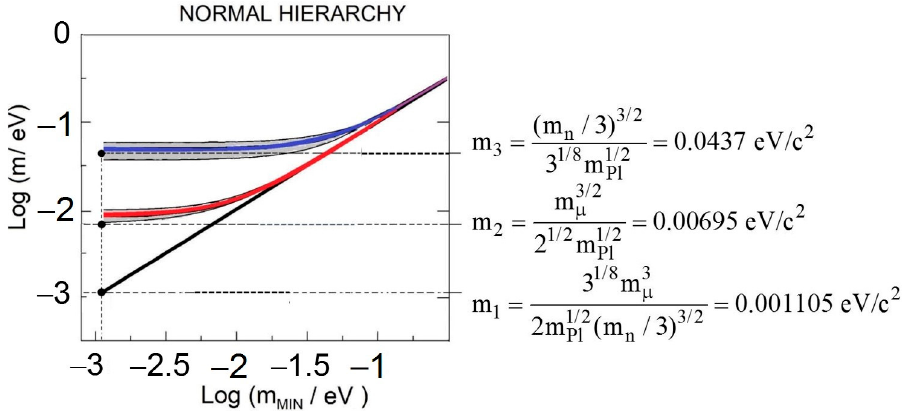
Figure 1. Comparison of computed via the RLM (horizontal dotted lines) [12] and experimental [14,15] neutrino eigenmasses; m n and m μ are the neutron and muon masses, respectively. The m 3 , m 2 , and m 1 expressions were retrieved from [12]. These equations imply that, interestingly, m 3 /m 2 = m 2 /m 1 ≈ 6.3 ≈ 2 π .